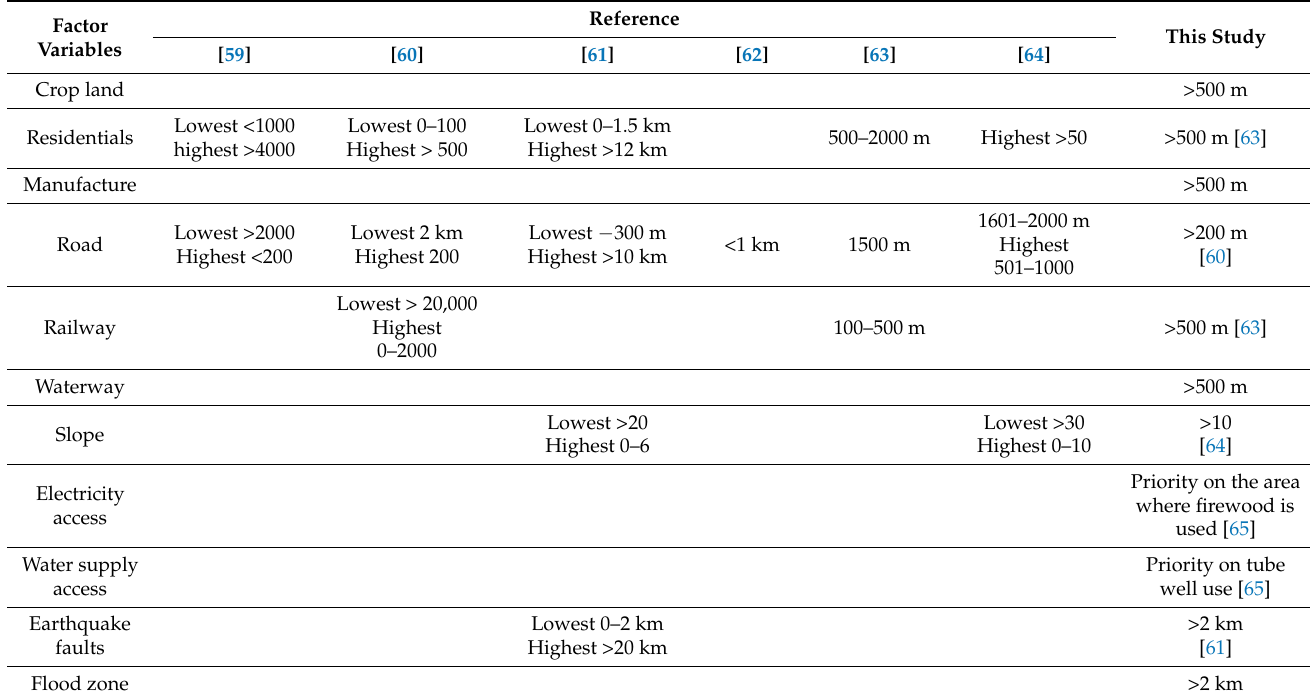
Table A4. The Criteria of Factors Variables and Preference